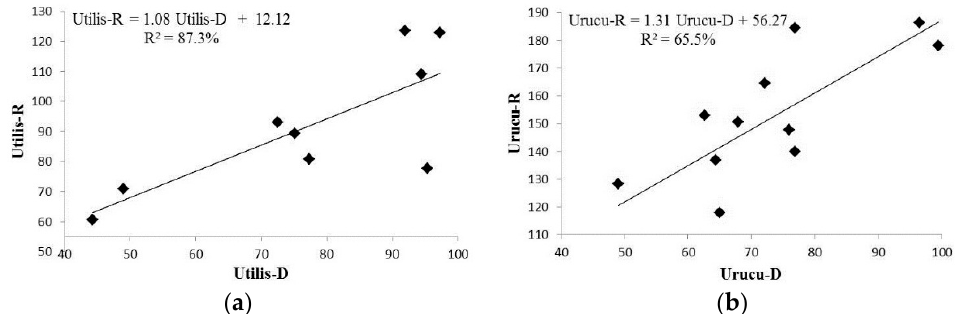
Figure 3. Regression model for both species with respective equation, wherein ( a ) Utilis-R and Utilis-D correspond to rotenone and deguelin concentrations on D. utilis roots samples, respectively; and ( b ) Urucu-R refers to rotenone, and Urucu-D to deguelin concentrations on D. rufescens var. urucu root samples.